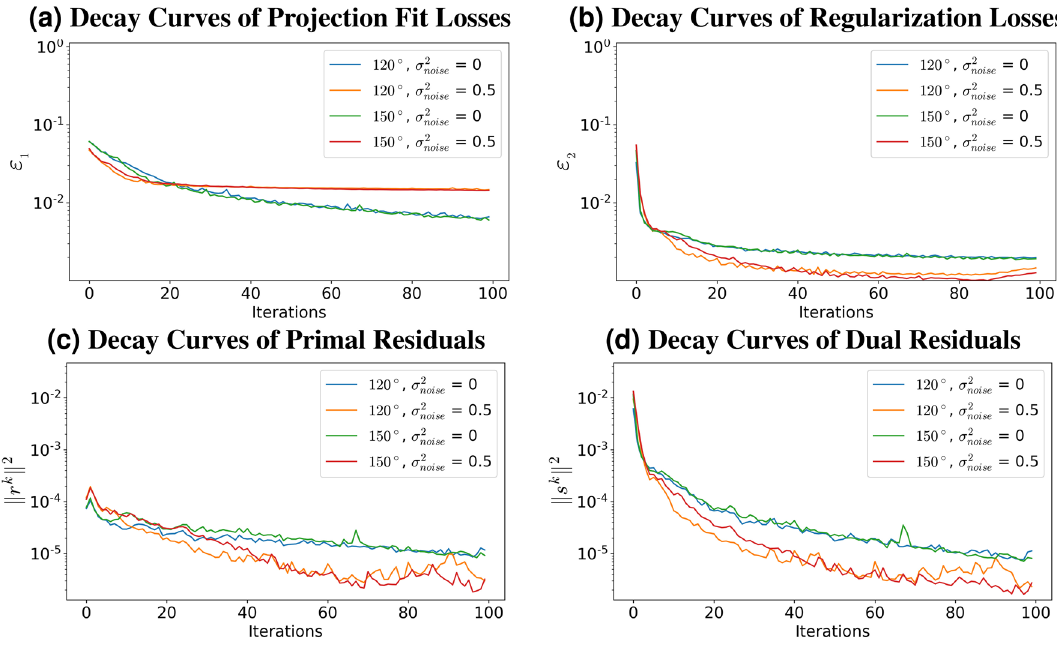
Figure 4. Convergence curve